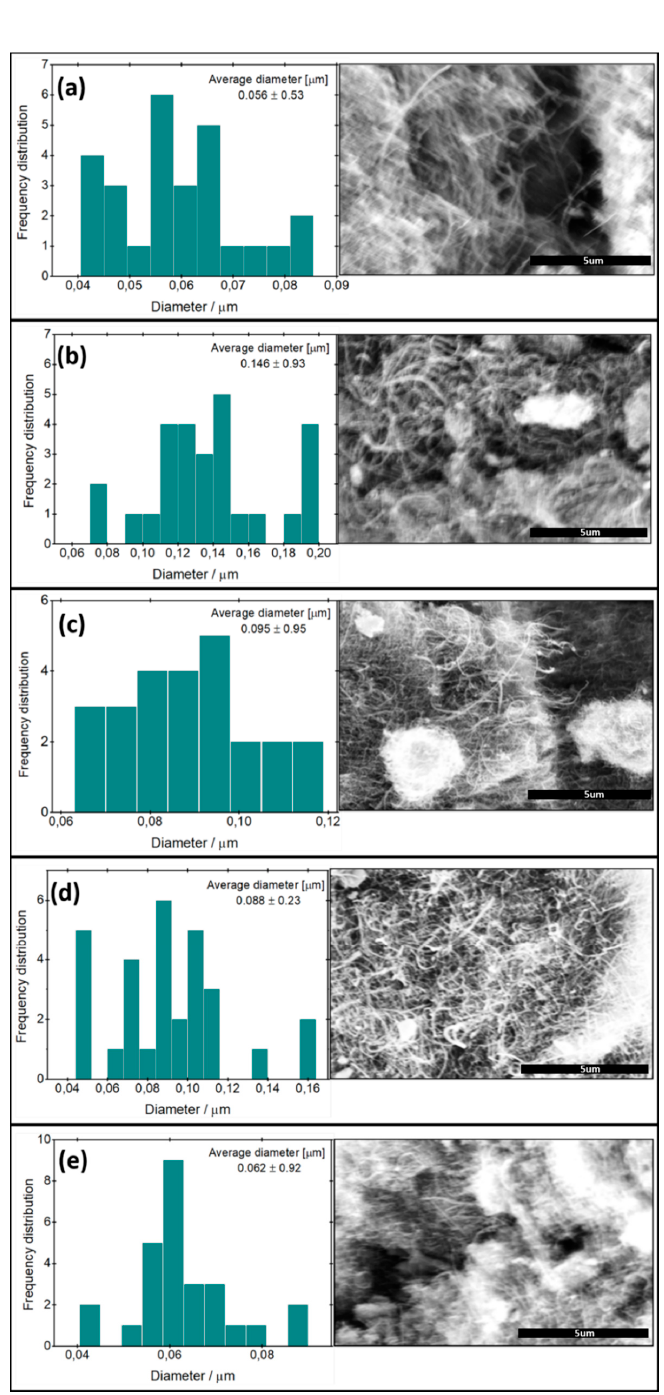
Figure 2. SEM images of the original and the modified carbon nanotube (right), together with diameter distribution (left). ( a ) MWCNT, ( b ) MWCNT–COOH, ( c ): m-MWCNT–HA, ( d ) m-MWCNT–CYS, and ( e ) m-MWCNT–HYD. Scale bars: 5 µm.